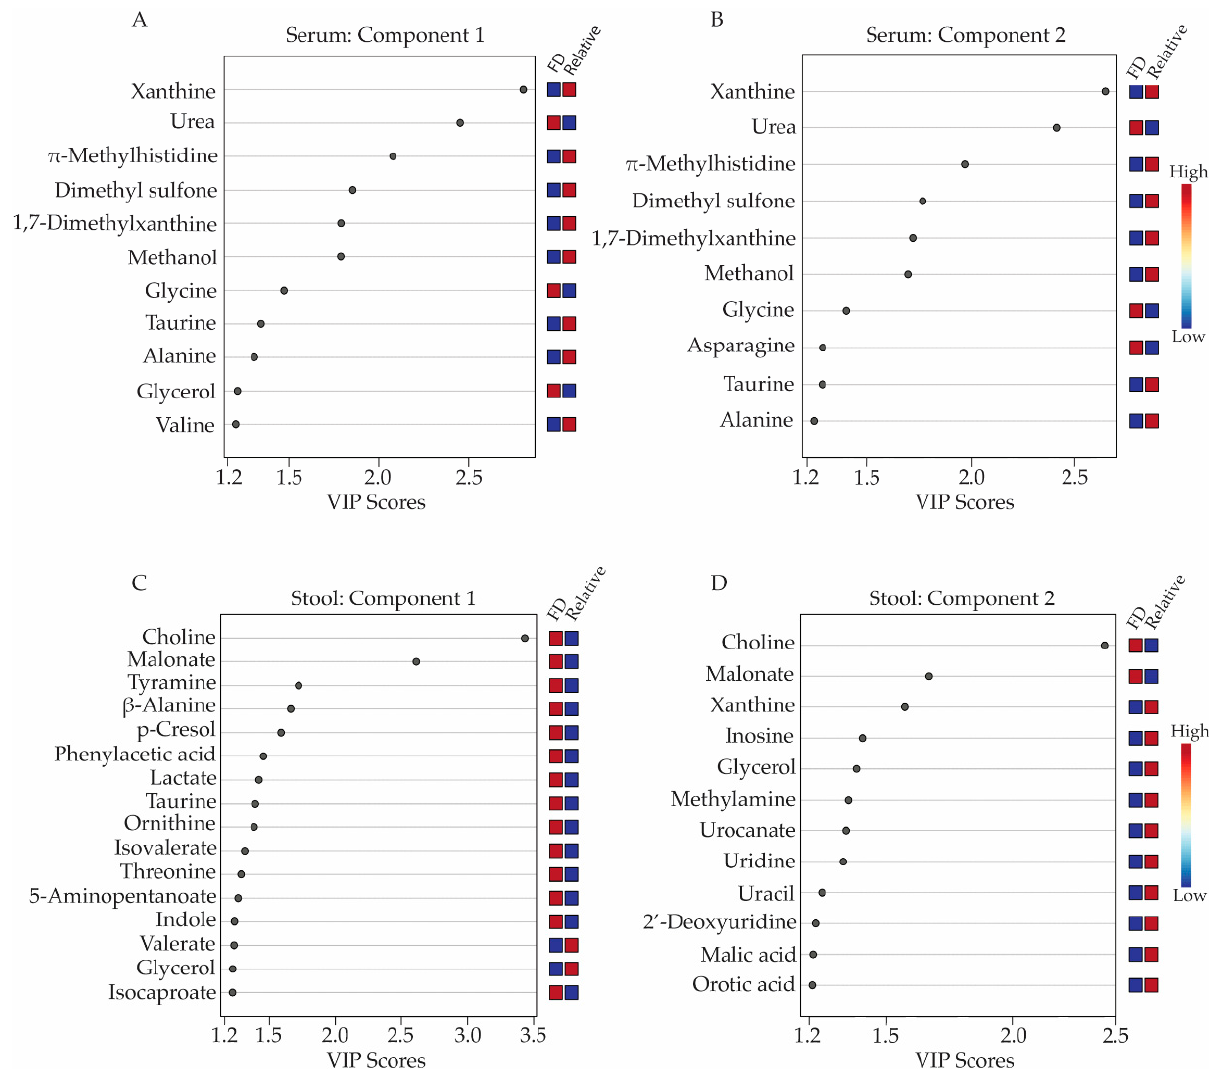
Figure 2. Variable importance in projection (VIP) score plots corresponding to the first two compo- nents of the 3D-PLS-DA models obtained from serum and stool metabolite profiles. Metabolites with VIP scores ≥ 1.2 were considered a significant contributor to the distinct clustering of the FD patient and the healthy relative control groups along components 1 and 2 of the 3D-PLS-DA scores plots. Panels ( A , B ) display the VIP score plots for the serum metabolites, while panels ( C , D ) presents the VIP score plots for the stool metabolite profiles. Relative metabolite levels range from high (red boxes) to low (blue boxes), indicating whether the metabolite concentrations are higher or lower in the FD patient group relative to the levels measured in the healthy relative control group. All VIP scores plots shown in Figure 2 have been generated from PLS-DA modeling conducted in MetaboAnalyst v.4.0 (Edmonton, AB,